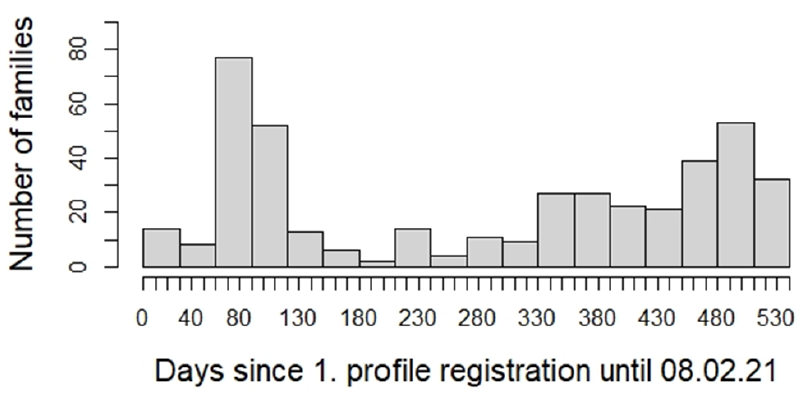
Figure 3. Participation time since first profile registration in days.